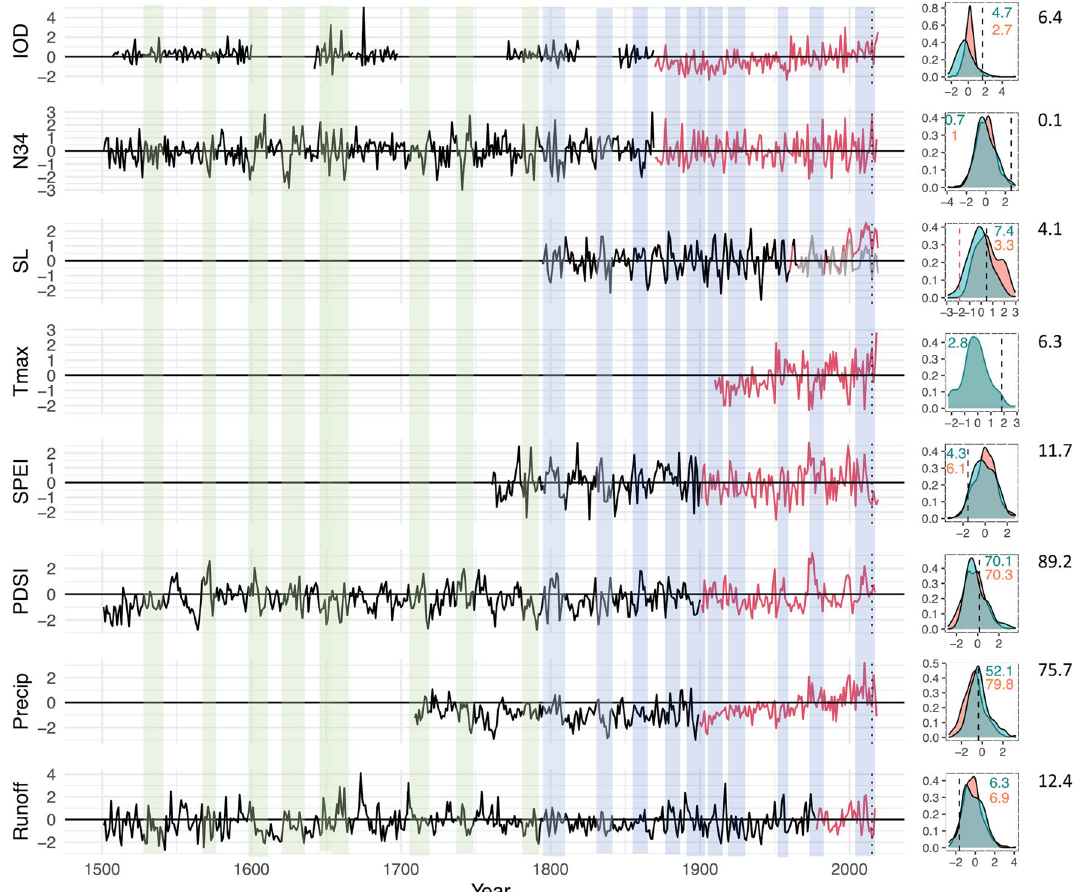
Figure 2. Left panel: Time series (z-scores relative to the 1961–90 period) of reconstructed and instrumental indices (IOD, Niño3.4) and climate variables (Sea level, maximum temperature; SPEI3, PDSI, precipitation (AWAP data); Alligator River run off) relevant for northern Australia. For sea level, red line is the non- detrended sea level data while grey line is the detrended data. Right panel: associated probability distributions, red is for reconstructed series, and teal for instrumental data. Vertical black lines show where in the distribution the 2015–16 value fell. Red line in sea level distribution shows value for 2015–16 once data detrended, black line is for non-detrended data. Numbers in upper left or right relate to the empirical probability (as percentages) of experiencing an event in that variable at least as extreme as that in 2015. Colours match the respective distributions. For sea level, figures are based on detrended sea level